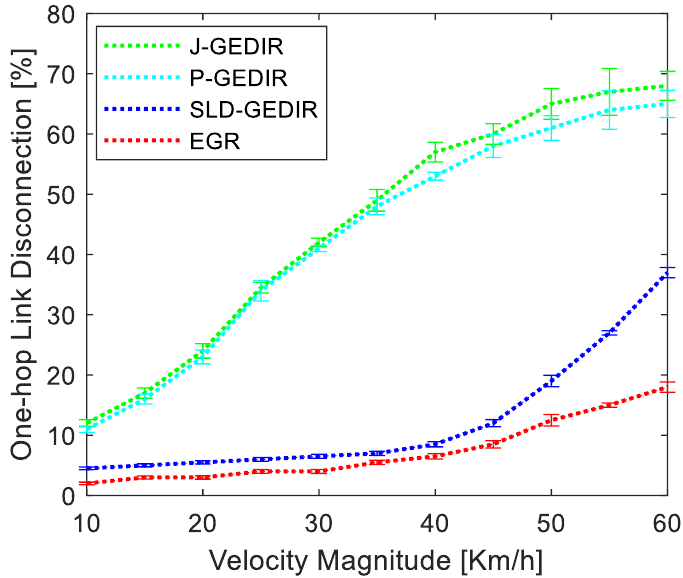
Figure 13. Effect of Velocity on one-hop link disconnection.